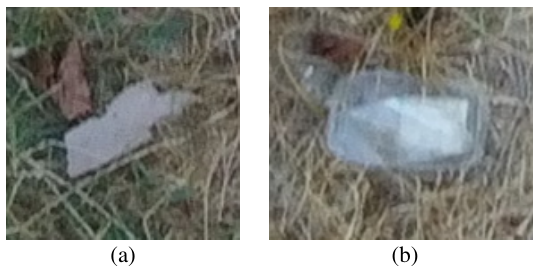
Figure 6. Examples of detection errors: (a) false positive, (b) false negative.